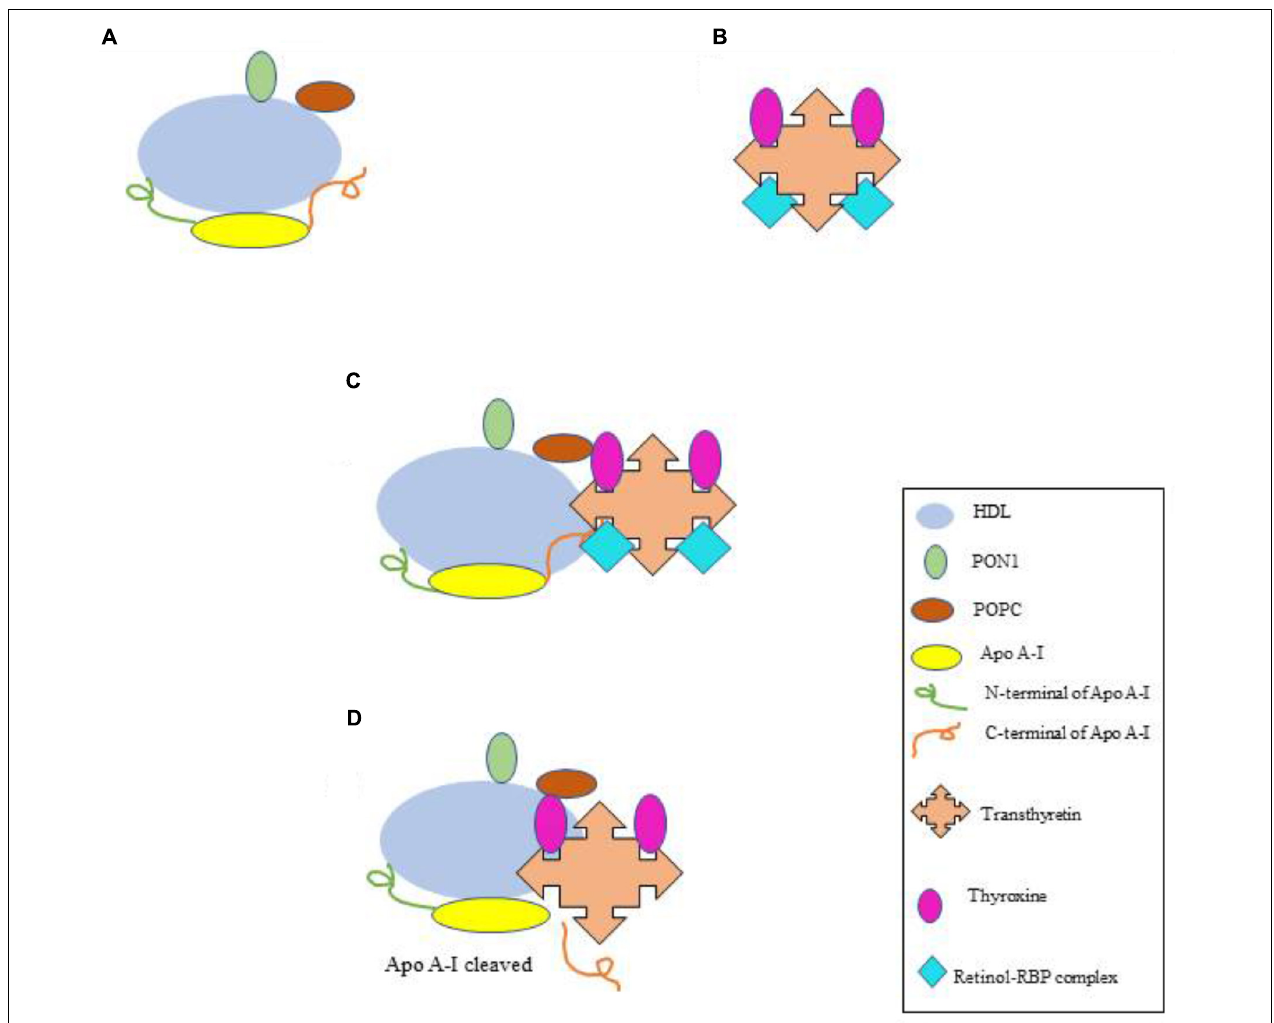
FIGURE 1 | Cryptic protease activity of TTR and cleavage of Apo A-I. (A) HDL complex associated with the antioxidant enzymes. (B) TTR protein bound to thyroxine and retinol-RBP complex. (C) HDL complex with TTR. TTR exhibits no cryptic protease activity until it is bound to retinol-RBP complex. (D) Cryptic protease activity of TTR when retinol-RBP complex is not bound, Apo A-I is cleaved into N and C-terminal. HDL, high density lipoprotein; PON1, paraoxonase; POPC, 1-palmitoyl-2-oleoyl-phosphatidylcholine; RBP, retinol binding protein; TTR,